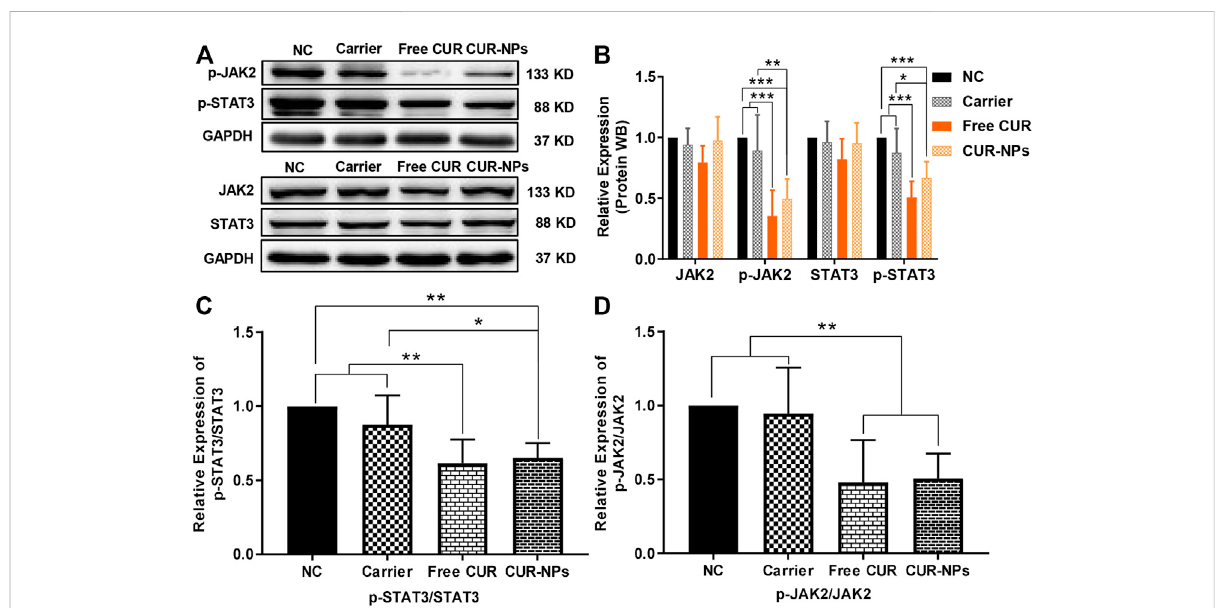
FIGURE 11 EffectsofCURandCUR-NPsontheexpressionsofproteinsrelatedtotheJAK/STAT3signalingpathwayinMDA-MB-231cells. (A,B) Theprotein expression levels of JAK2, p-JAK2, STAT3, and p-STAT3 were detected by Western blotting. (C) The ratio of p-STAT3/STAT3 was relative to the negative control group. (D) The ratio of p-JAK2/JAK2 was relative to the negative control group. * p < 0.05, ** p < 0.01, *** p <